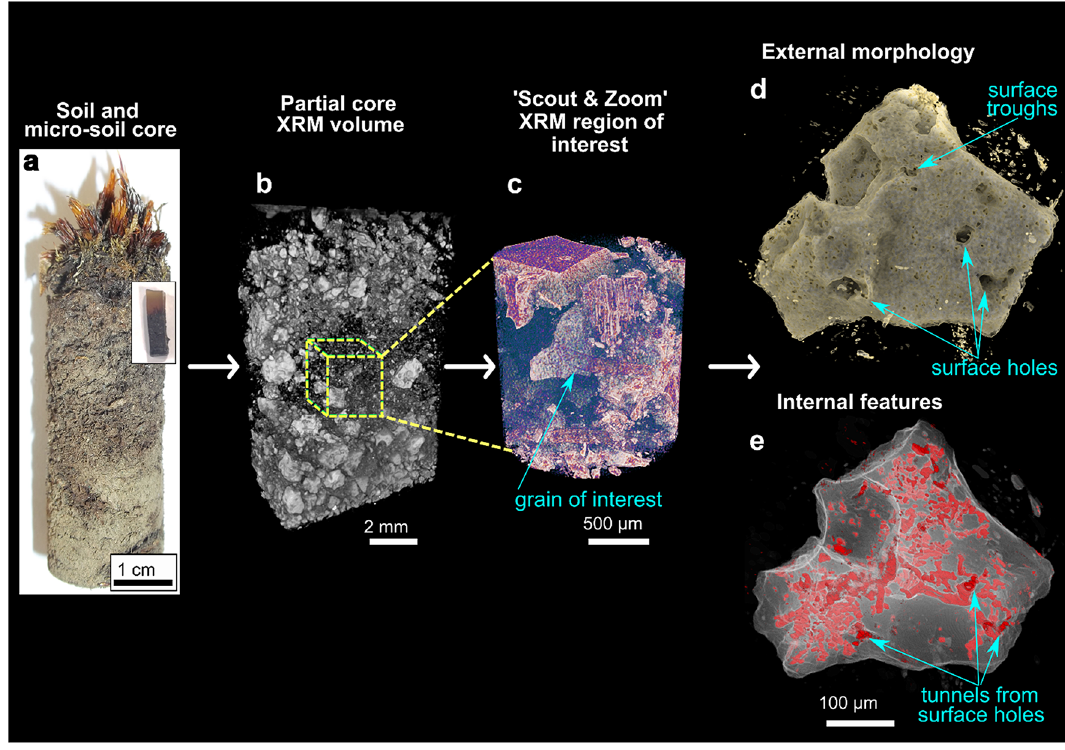
Figure 1. The correlative 3D imaging process: illustrates progressive higher resolution study from whole CGC soil core (a), to micro-core, Scout and Zoom feature on ZEISS Xradia Versa 520 (b, c), and finally segmentation of grain tunnels (d, e) (also see Supplementary Videos